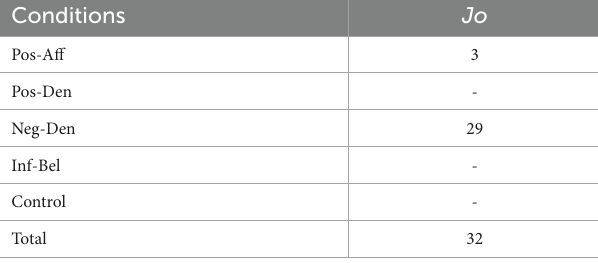
TABLE 2 Productions of sentence-initial response particle jo by condition.